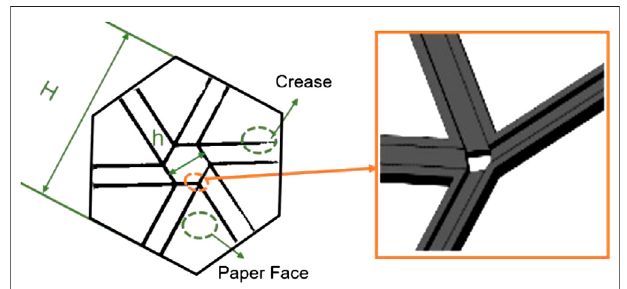
FIGURE 1 | Fabrication of the hexagon-twist origami structure. The multimaterial 3D printed hexagon-twist origami structure with the speci fi c design parameter. H denotes the height of outer hexagon. h denotes the height of inter hexagon. The design details about the vertex is shown in the illustration.